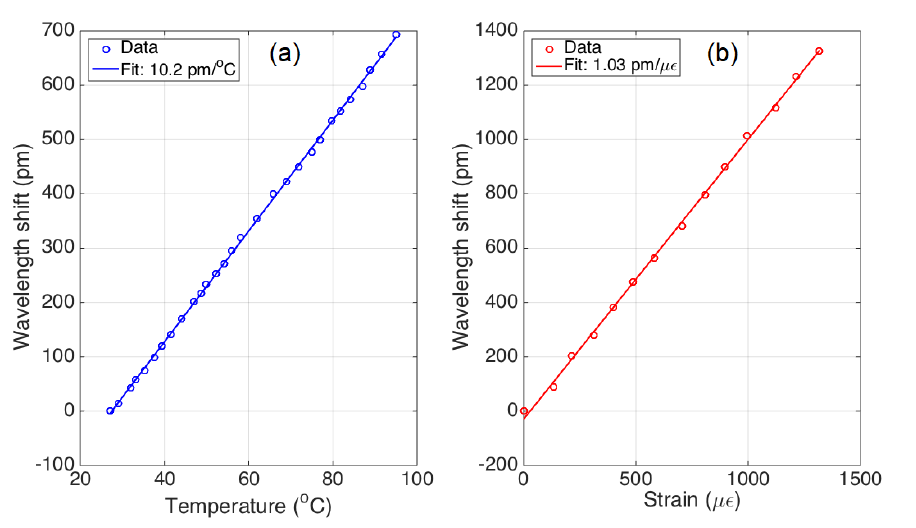
Figure 3. Experimental characterization of temperature ( a ) and strain coefficients ( b